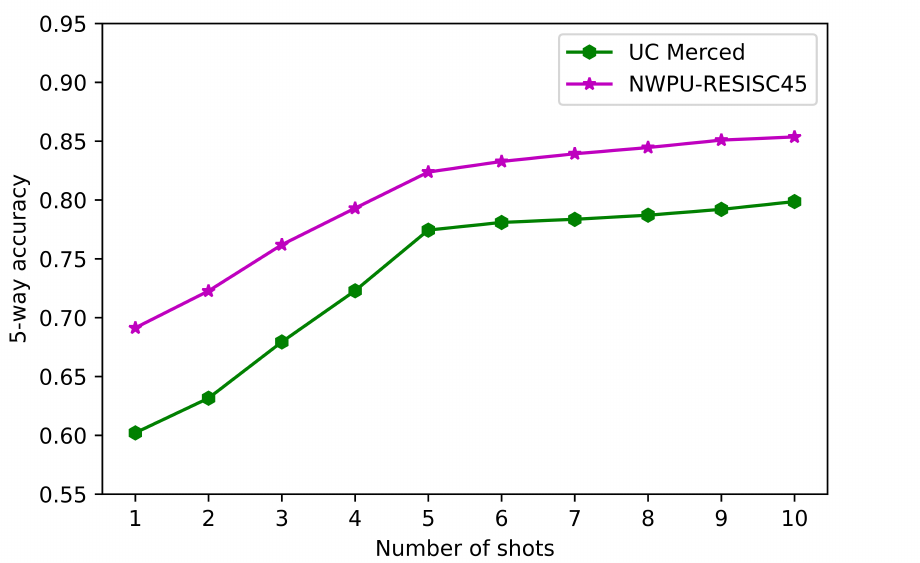
Figure 10. The influence of different shots on 5-way accuracies is presented with 95% confidence interval, in which the experiments are performed on UC Merced and